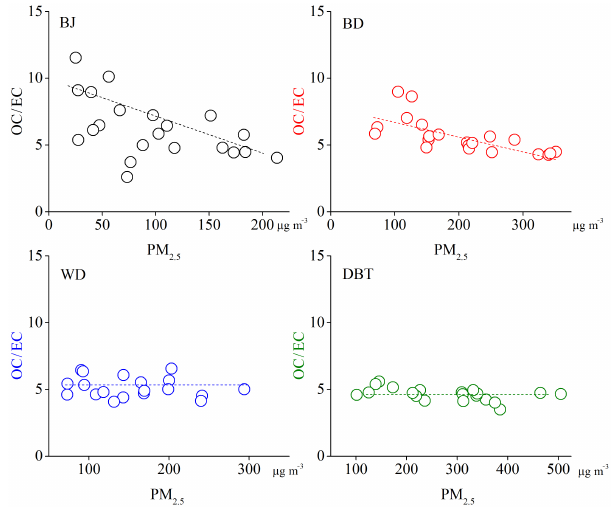
Figure 9. The correlations between the OC / EC ratios and the PM 2 . 5 concentrations at the four sampling sites during the sampling period in the winter of